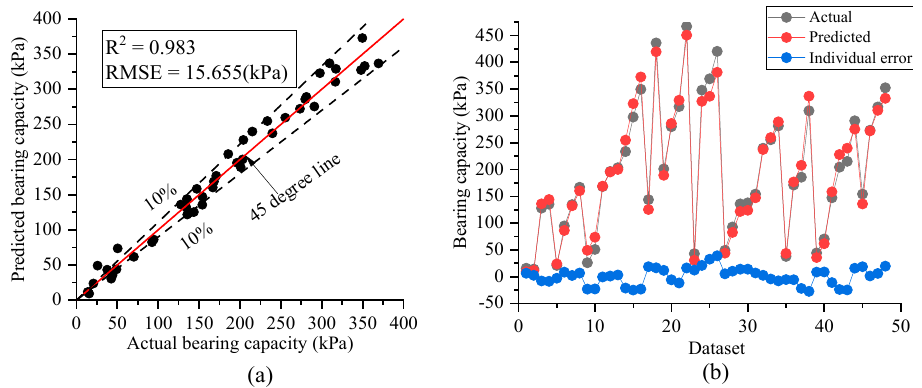
Figure 5. ( a ) Comparison of the predicted, from the MPR model, and actual q rs for the testing data; ( b ) the residual and match between the measured and predicted q rs values for each test data point. Table 3. Values for the independent variables and their associated actual vs. predicted results from the MPR